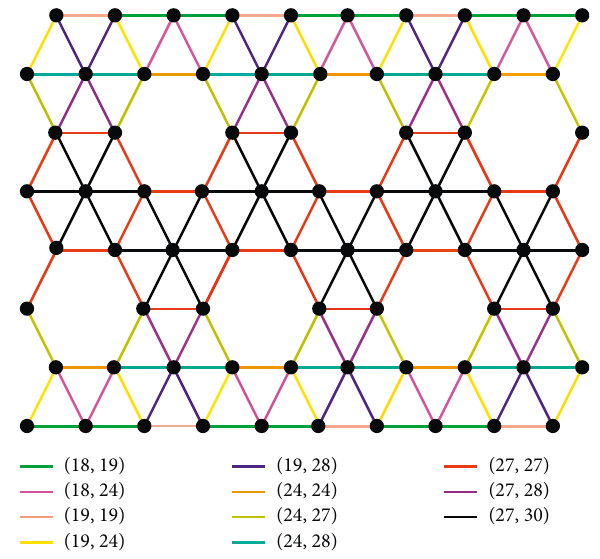
Figure 5: The edge partitions of BA ( X )[ 8 , 6 ] with respect to degree sum of neighbor